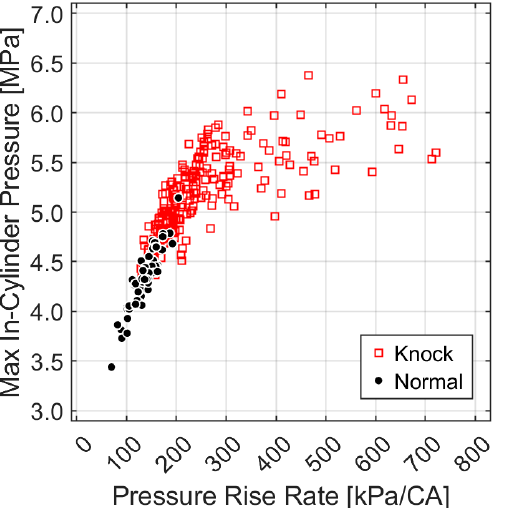
Figure 6. Maximum in-cylinder pressure and pressure rise rate of knock and normal cycles.